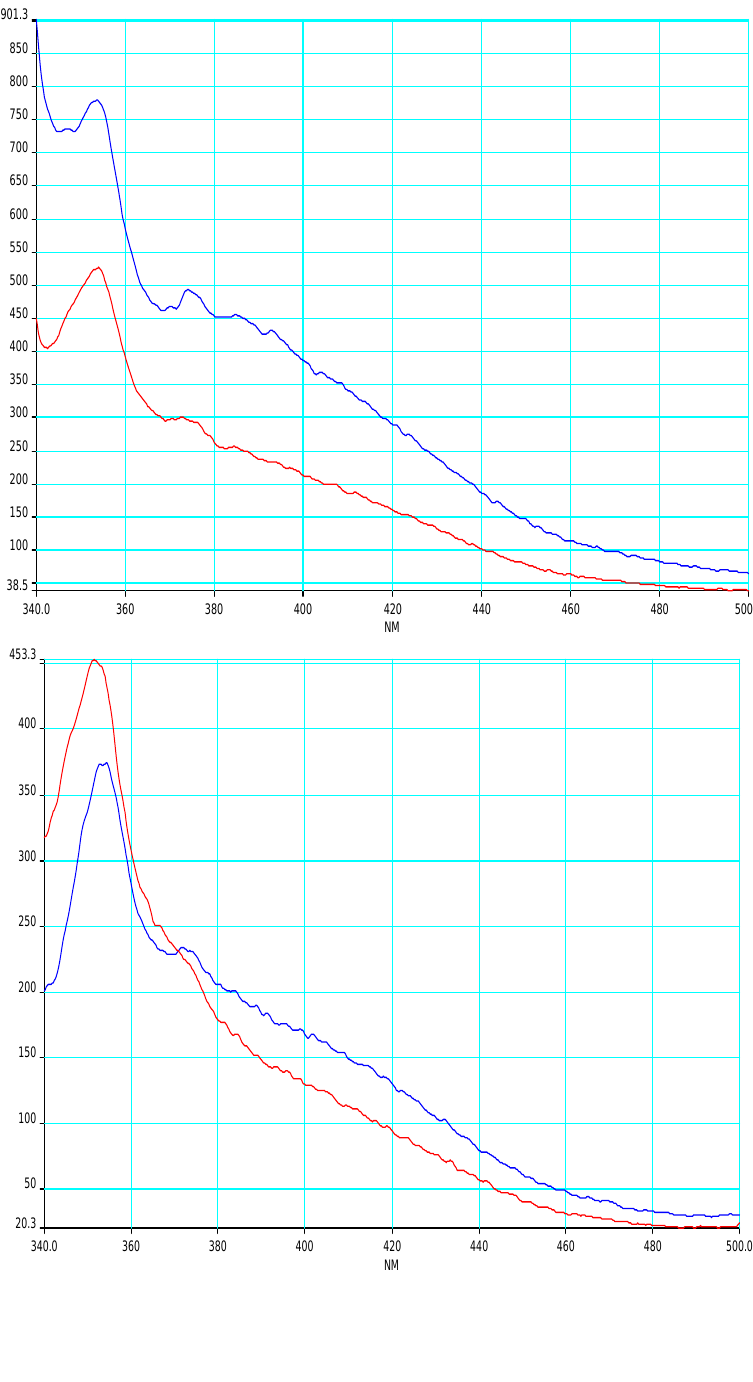
Figure 2 : Emission spectrum of ACN in solution (red line) and gels (blue line) of 4 (11.5 mM) at 0.18 mM (upper) and 0.93 mM